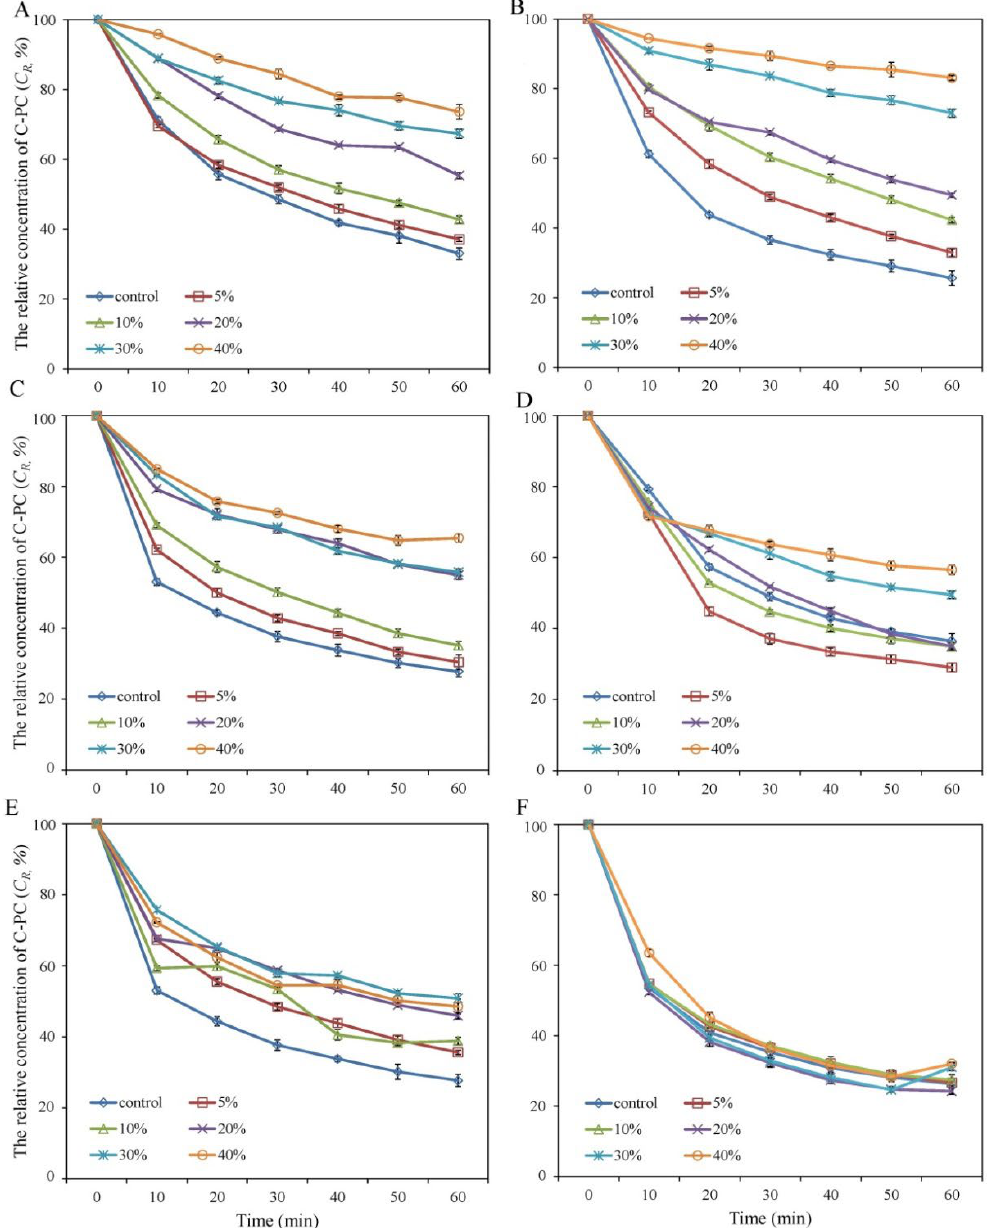
Figure 1. Change in relative concentration of C-PC during incubation with different concentration of additives at 65 °C. ( A ) (glucose); ( B ) (mannose); ( C ) (mannitol); ( D ) (galactose); ( E ) (maltose); ( F ) (maltitol).